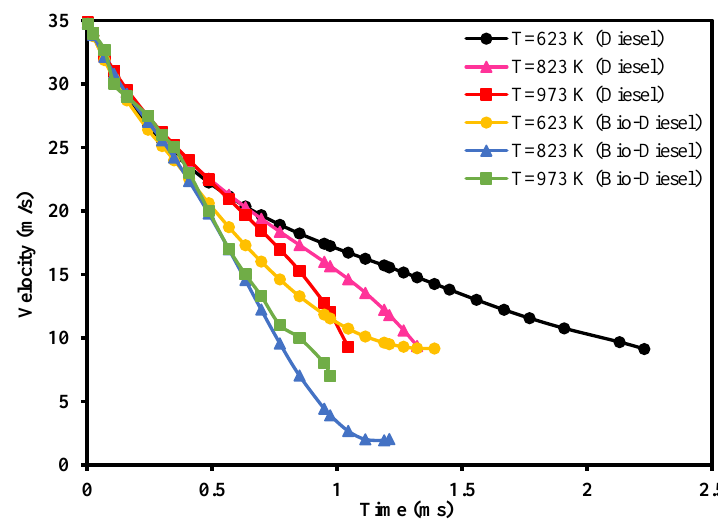
Figure 8. Variation in velocity of 20-micron droplet at different ambient temperatures.